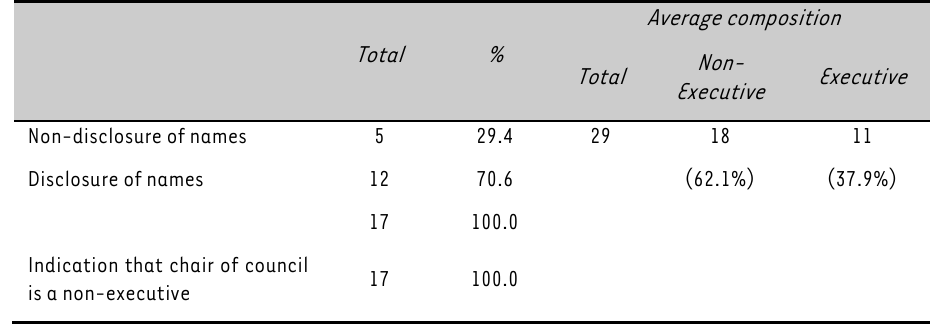
TABLE 3: Council disclosure